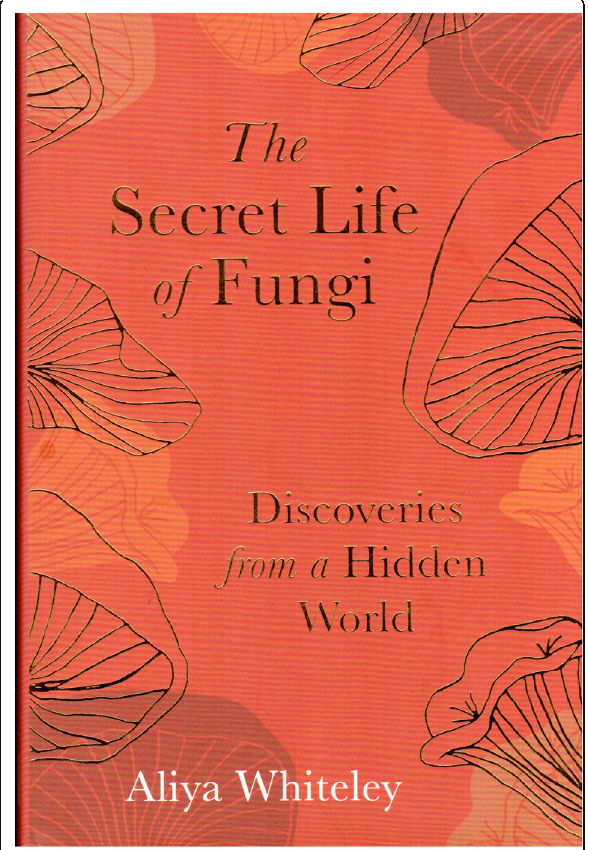
Fig. 42 Secret Life of Fungi